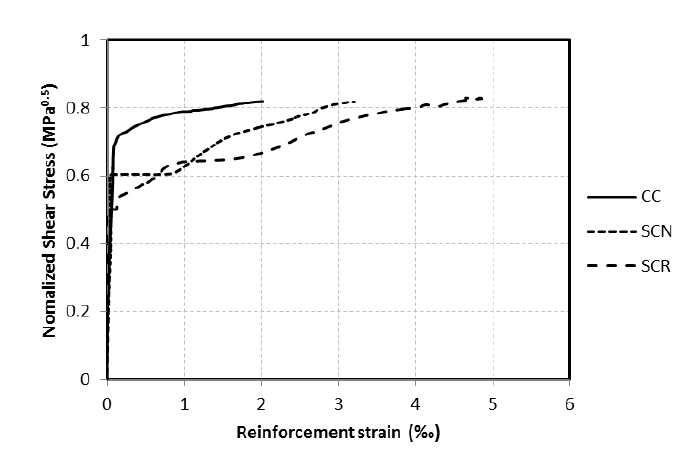
Figure 7. Normalized shear stress vs. reinforcement